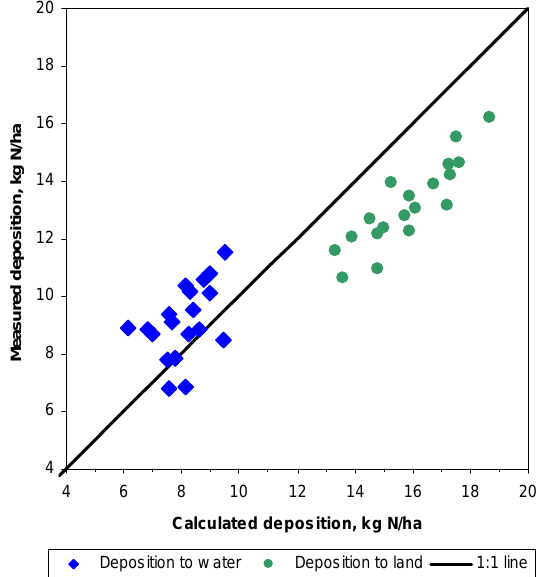
Fig. 2. Measured and modelled annual nitrogen deposition at five monitoring sites in Denmark in the period 1990–2009 (Ellermann et al., 2010). Deposition to land is a mean over all five sites and calculated with a deposition velocity for the actual land surfaces. Deposition to water (blue squares) is a mean over two of the sites (located close to the coast) and calculated with a deposition velocity for water surfaces.